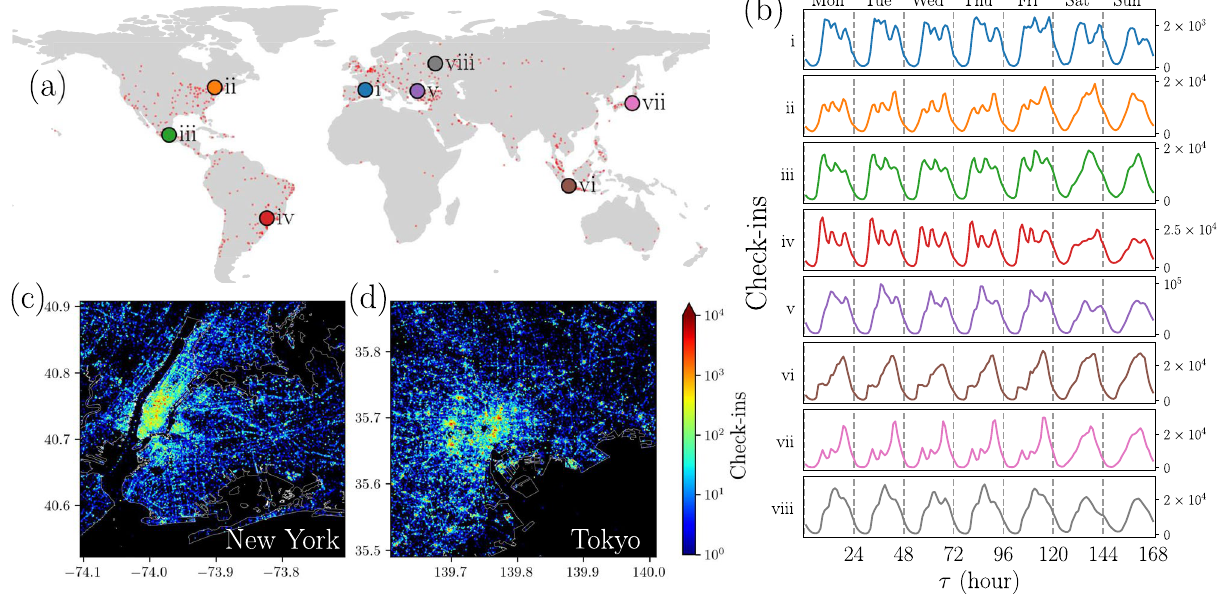
Figure 2. Spatial and temporal analysis of check-ins in different cities. ( a ) 632 cities worldwide analyzed, represented with small dots, and eight selected cities: (i) Barcelona, (ii) New York, (iii) Mexico City, (iv) Sao Paulo, (v) Istanbul (vi), Jakarta, (vii) Tokyo, and (viii) Moscow. ( b ) Frequency counts for all the check-ins in the cities (i) to (viii) presented in ( a ) gathered using the local time when they were made. The counts reported in the histograms correspond to the number of check-ins in each hour of the week, from the first hour on Monday to the last hour on Sunday. ( c ) Points of interest in the Foursquare dataset in New York and ( d ) Tokyo. In this representation, the number of check-ins in the respective POI is codified in the colorbar. All figures were created using python 3.8 and the matplotlib (3.5.0) package (https:// matpl otlib. org). The map in panel ( a ) was created using the geopandas (0.12.1) package (https:// geopa ndas. org). Land borders in panels ( c ) and ( d ) were obtained from Open Street Maps Boundaries webpage (https:// osm- bound aries.